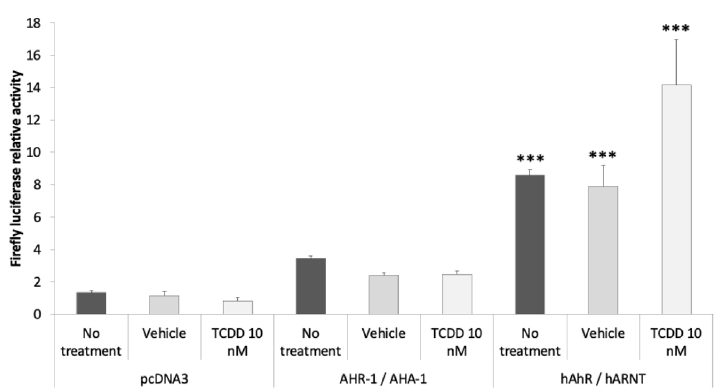
Figure 3. Comparison between Cos-7 cells transfected with C. elegans ahr-1 or human ahr . Cos-7 cells were transfected with the empty vector (pcDNA3) or with C. elegans ahr-1 / aha-1 or with human ahr / arnt . After transfection and culture for 24 h in 0% FBS medium, cells were treated for 24 h with 10 nM of TCDD. The relative activity represents the Firefly measurement normalized to the Renilla measurement for each condition. Three independent experiments were performed in duplicate, error bars represent SD. ANOVA followed with comparison test of each column with the control column (pcDNA3—No treatment) *** p ‐ value < 0.001.